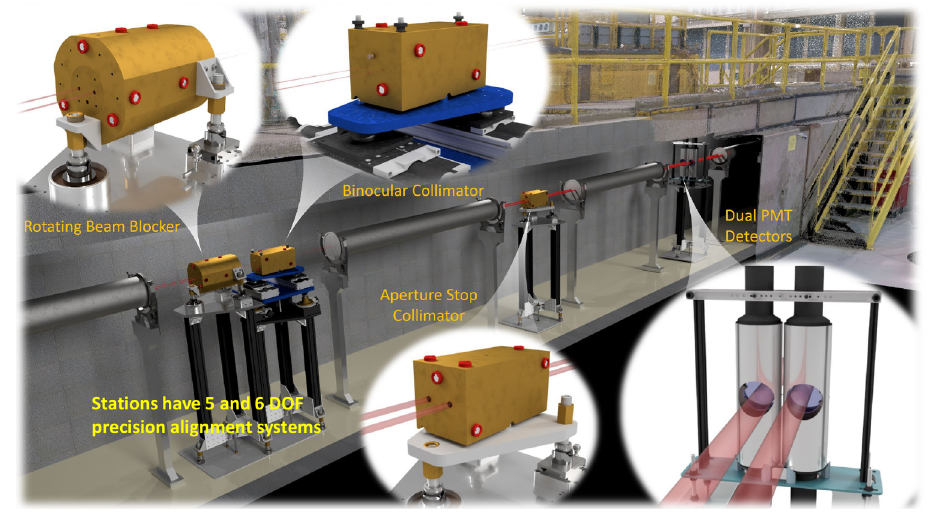
Figure 1. The DICER instrument is located at flight path 13, at Manuel Lujan Jr. Neutron Scattering Center at LANSCE. The collimation components along with the 31 m detection station are